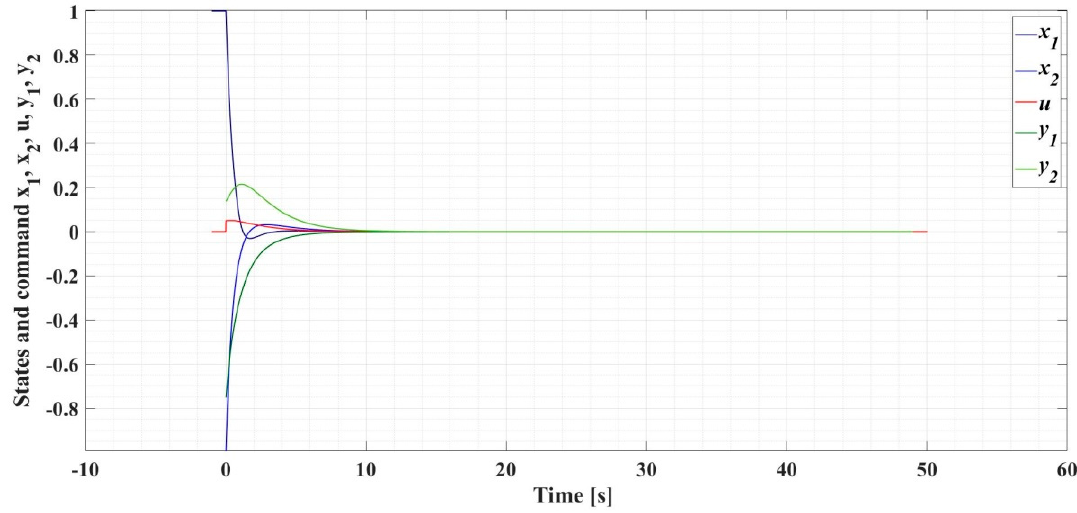
Figure 8. Evolution of the states with | u | ≤ 0.06.